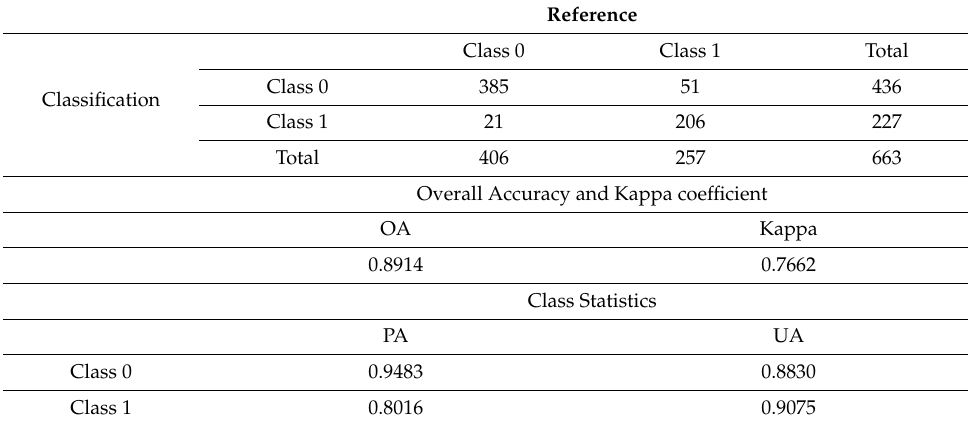
Table A8. S2 + GLCM MAX + Topo classification (“scheme 3”).